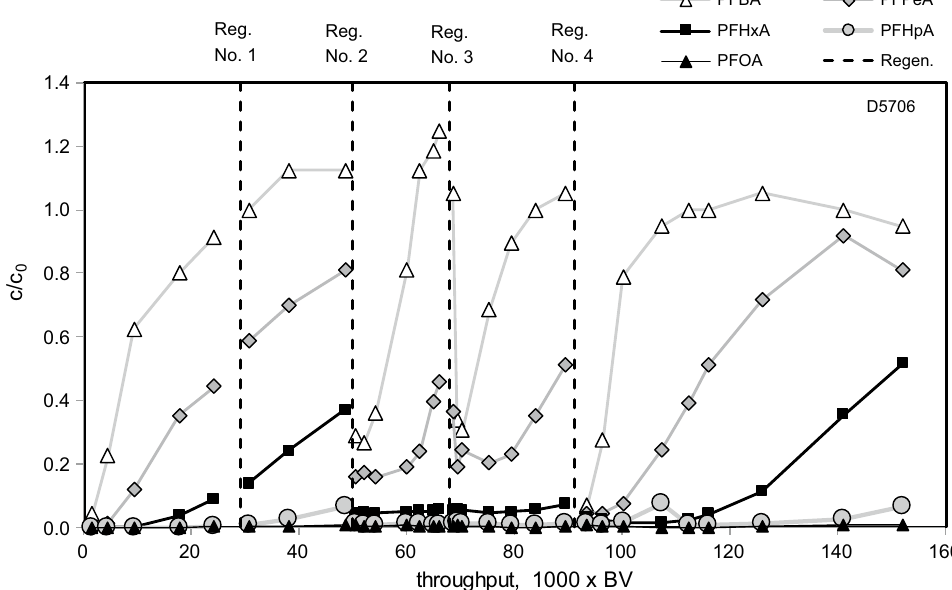
Fig. 7 Normalised breakthrough curves of PFAS from a real groundwater contamination for IEX D5706, regeneration number 1:3 BV of 1 M NaCl, regeneration number 2 and number 3:3 BV of 1 M NaCl in 45% ethanol, regeneration number 4: 6 BV of 1 M HCl in 45% ethanol